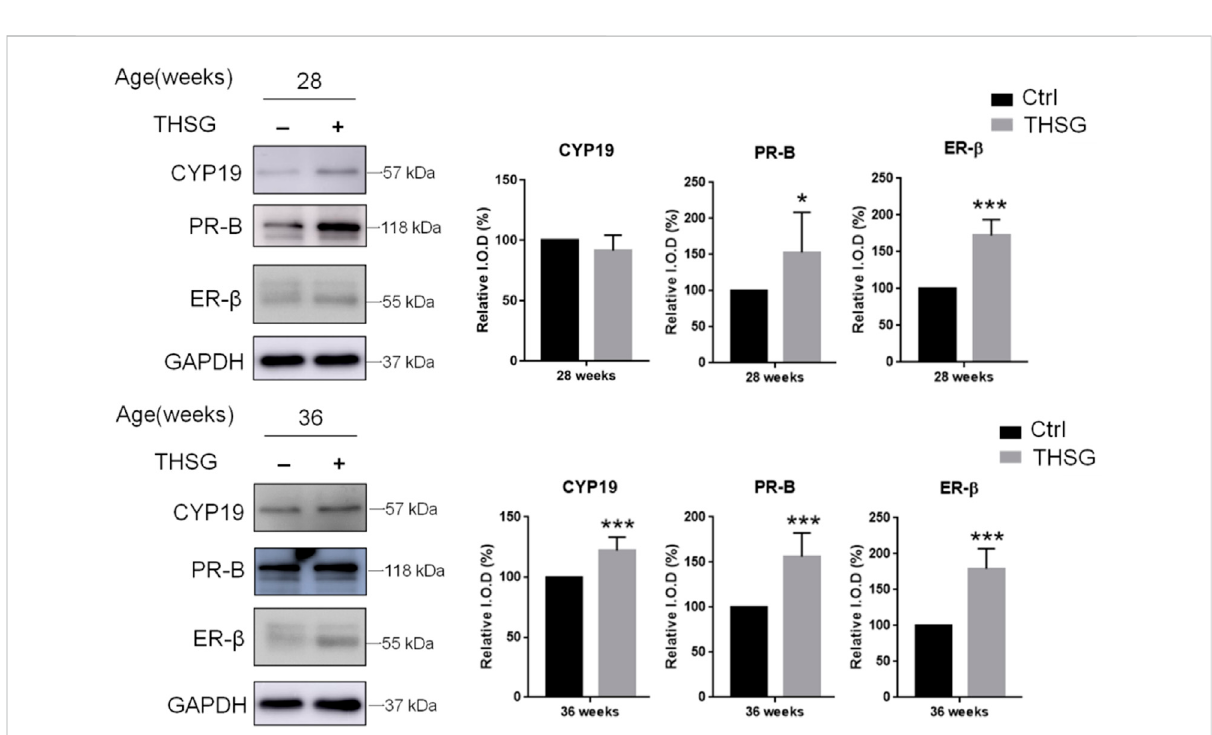
FIGURE 4 THSG stimulates steroidogenesis-associated proteins in aging young mice. Female C57BL/6J mice (4 weeks age-old) were received 10 mg/kg THSG(in50%ethanol;experimentgroup) orsolvent(50%ethanol;controlgroup)for6 weeks(28 weeksage-old)or8 weeks(36 weeksage-old) via gavage feeding. Ovaries of each mouse were collected from oviducts 14 h after hCG administration. Total proteins of oocytes were extracted. Western blotting analyses were conducted for CYP19, PR-B, ER- β and GAPDH. Data are expressed as the mean ± SD; * p < 0.05 and *** p < 0.001, compared with control